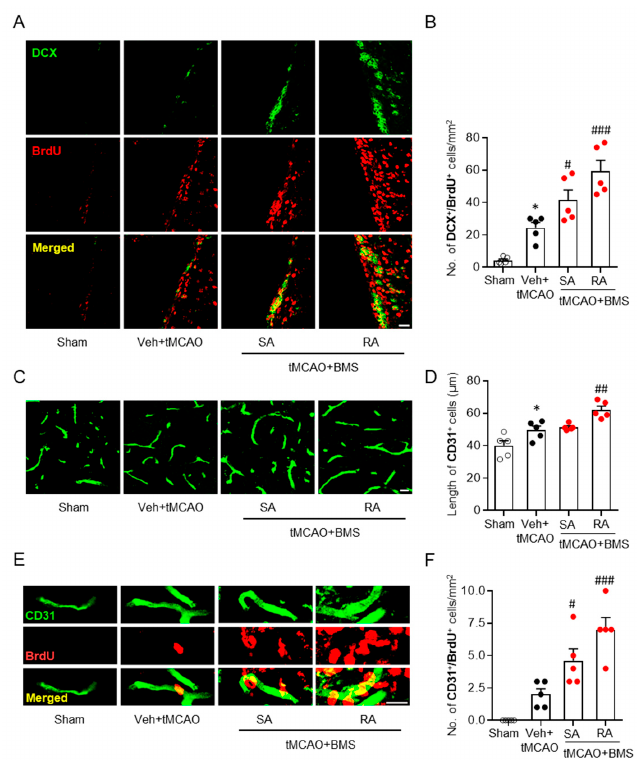
Figure 5. BMS administration promotes neurogenesis and angiogenesis in injured brains at fifteen days after tMCAO challenge. Mice were challenged with tMCAO. BMS (5 mg/kg) was administered either once immediately after reperfusion (single administration of BMS, “SA”) or daily (repeated BMS administration, “RA”) for 14 days after tMCAO challenge. ( A , B ) Effects of BMS on neurogenesis in the SVZ were determined by DCX/BrdU-double immunofluorescence staining. Representative images of DCX/BrdU-double positive cells in the SVZ ( A ) and quantification ( B ) are shown. ( C – F ) Effects of BMS on angiogenesis were determined by CD31/BrdU-double immunofluorescence staining. Representative images of CD31 ( C ) and quantification of lengths of vessels ( D ) are shown. Representative images of CD31/BrdU-double positive cells ( E ) and quantification of numbers of CD31/BrdU-double positive cells ( F ) are shown. Scale bars, 20 μ m in A and E and 10 μ m in C. n = 5 mice per group. * p < 0.05 versus sham. # p < 0.05, ## p < 0.01, and ### p < 0.001 versus vehicle- administered tMCAO mice (Veh + tMCAO).